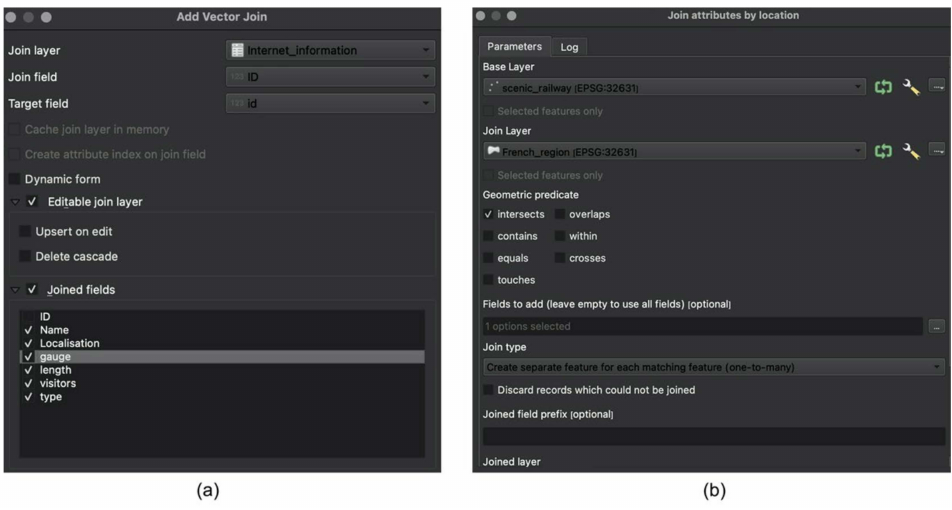
Figure 5. “Add vector join ( a )” and “Join attribute by location ( b )” in